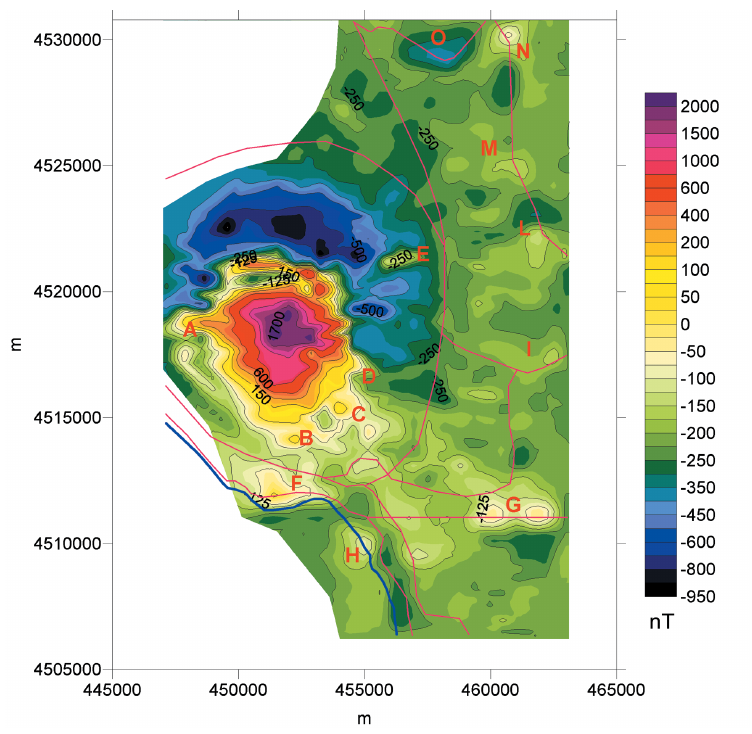
Fig. 9. Filtered map (localized filtering along the railway lines) of the new magnetic data set of the Vesuvian area. The red lines show the railway lines, the blue line shows the